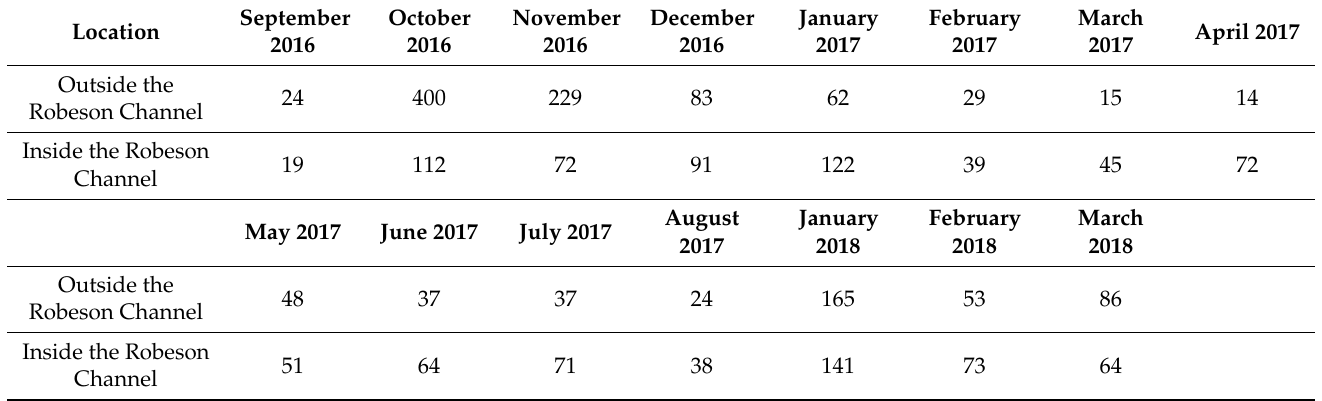
Table 2. Monthly samples of ice floes extracted from the Sentinel-1 images for the regions inside and outside the Robeson